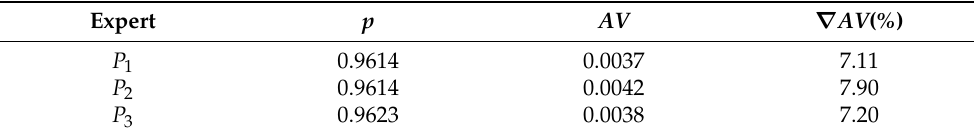
Figure 10. Global weights and their rankings. Table 18. Overall cardinal and ordinal group consensuses. Table 18. Overall cardinal and ordinal group